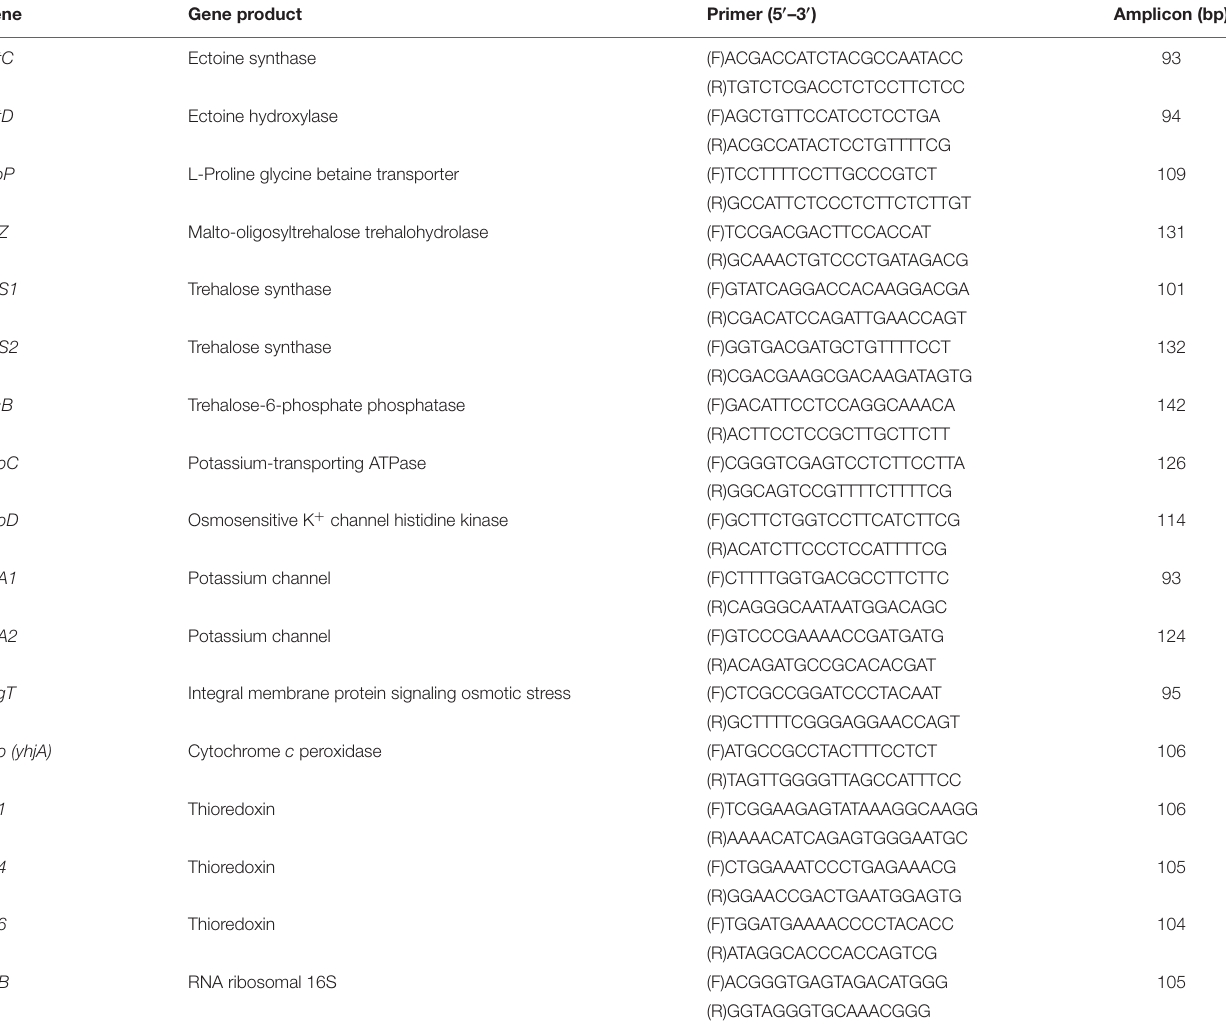
TABLE 1 | Primers used for